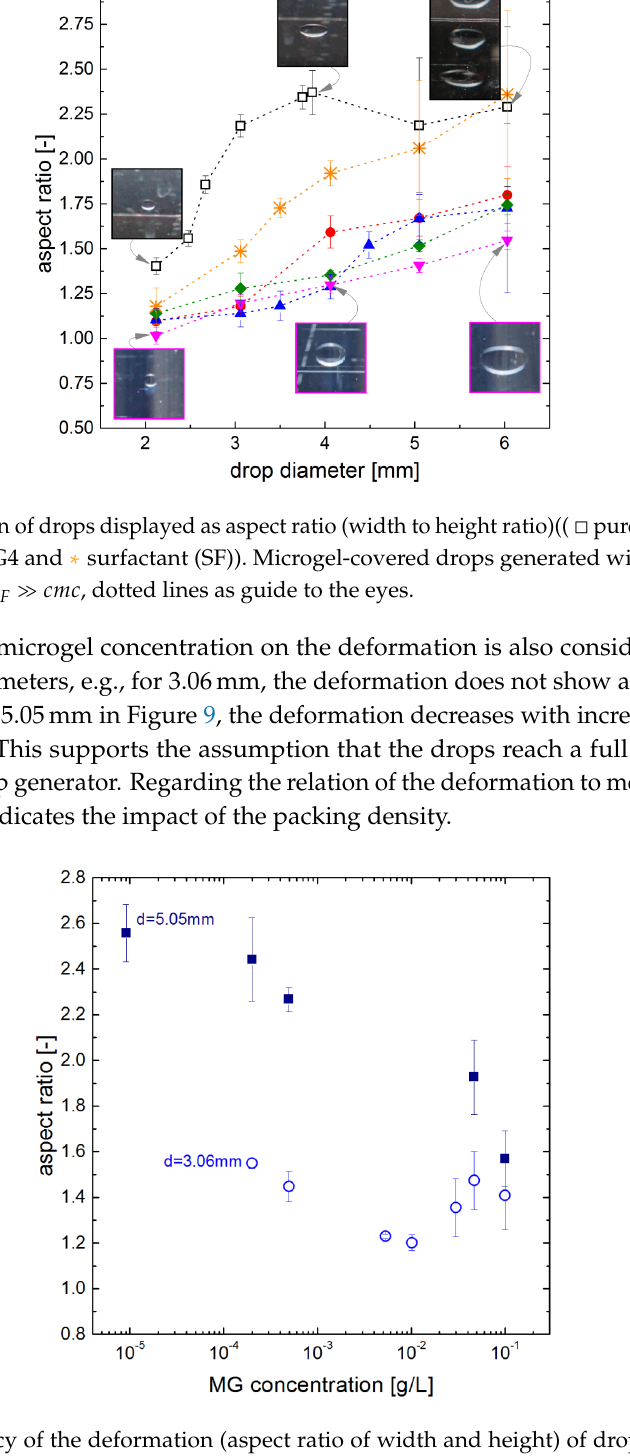
Figure 9. Dependency of the deformation (aspect ratio of width and height) of drops covered with MG4 on microgel concentration in the drop